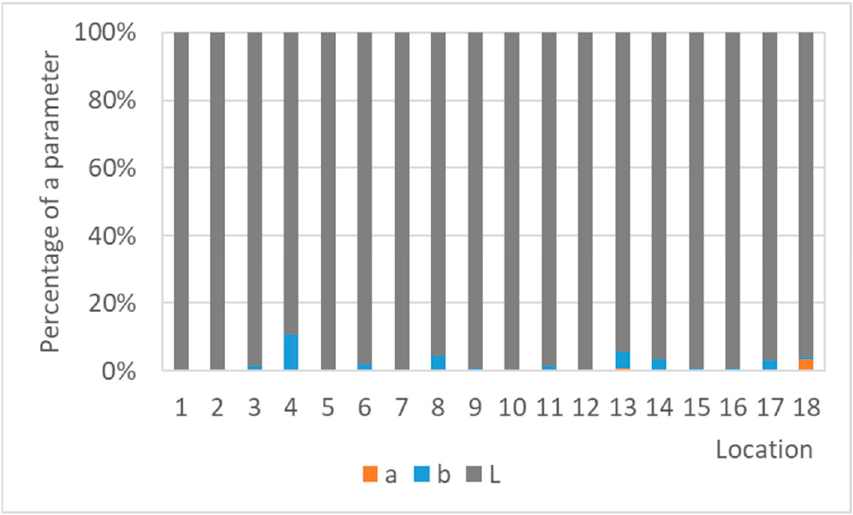
Figure 17. Percentage of the color parameters in the total color difference of lead coupons exposed for a year.